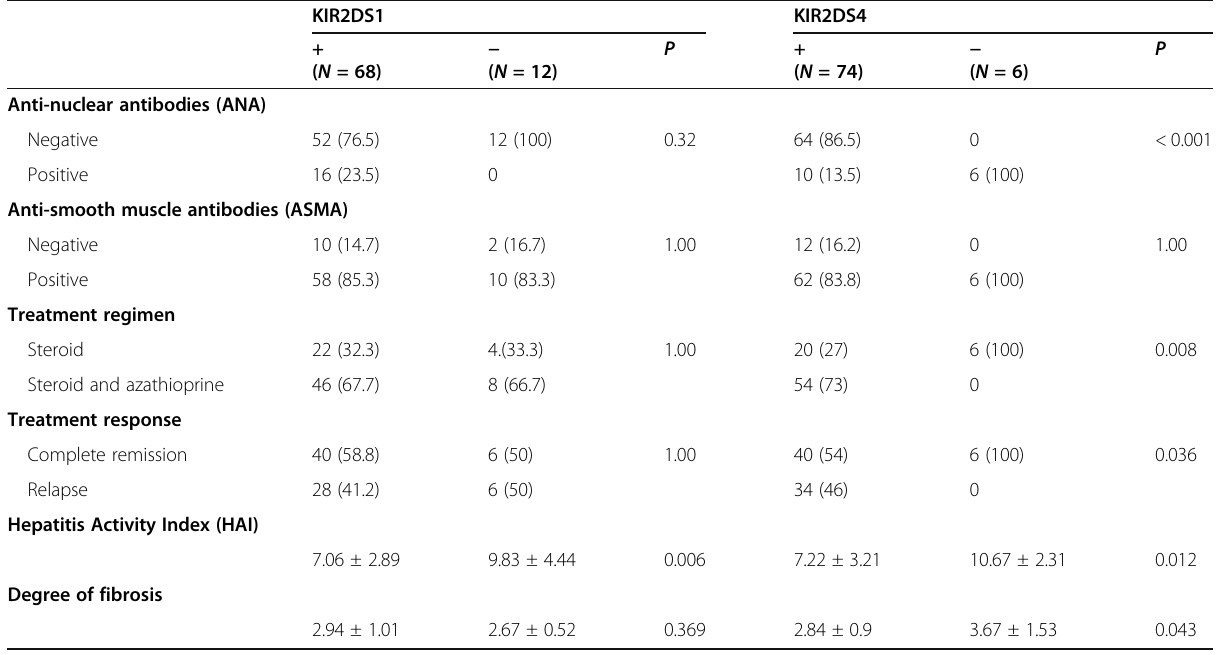
Table 3 Comparison of studied KIR activating genes and some disease characteristics in AIH-I patients